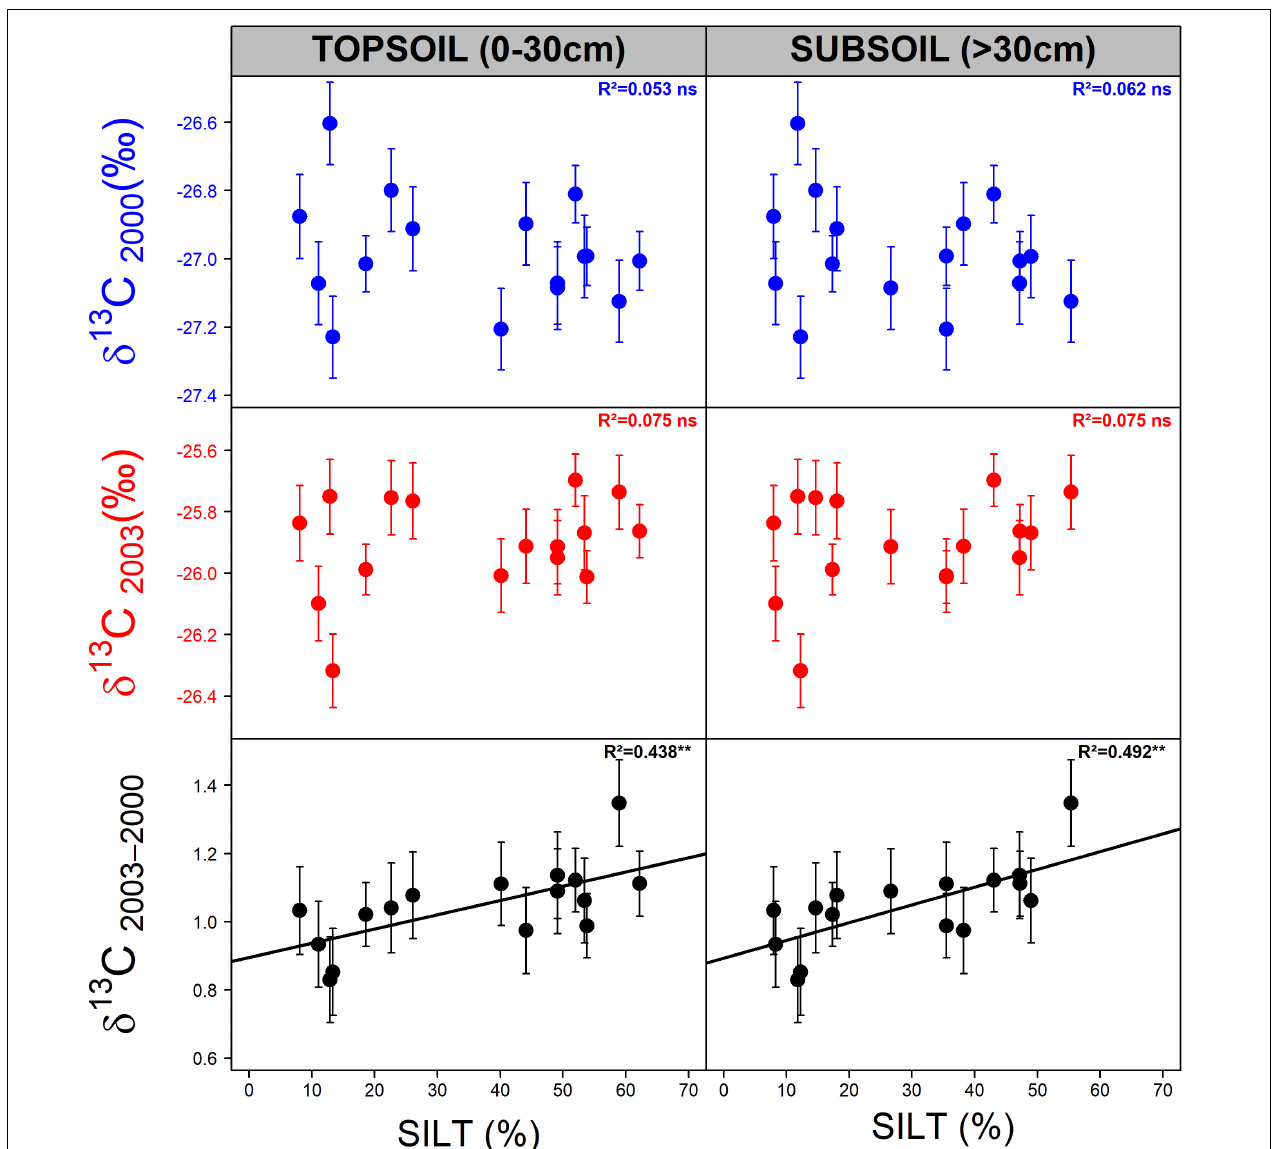
FIGURE 5 | Relationship between population δ 13 C in 2003 (red), δ 13 C in 2000 (blue) and δ 13 C 2003 − 2000 (plasticity of δ 13 C to severe drought) and the percentage of silt in the soil of their provenance sites. Topsoil represents the first 30 cm of the soil (in depth), and subsoil represents the profile below 30 cm down to the rooting depth. The error bars represent the standard error of the mean. For each correlation, the coefficient of determination ( R 2 ; n = 16) and the significance level (ns: p > 0.05; **: 0.001 < p < 0.01) are shown.